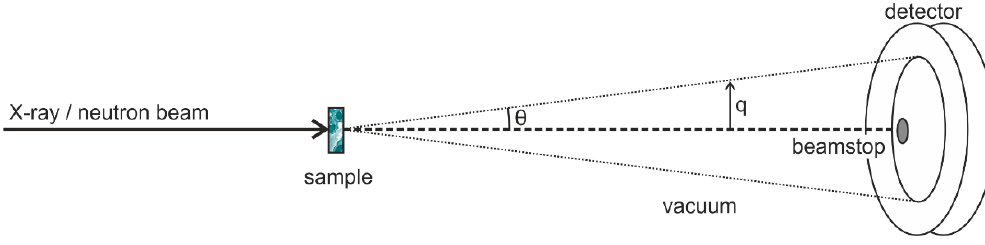
Figure 1. Layout of a conventional small angle X-ray or neutron scattering setup. Adapted from [6].